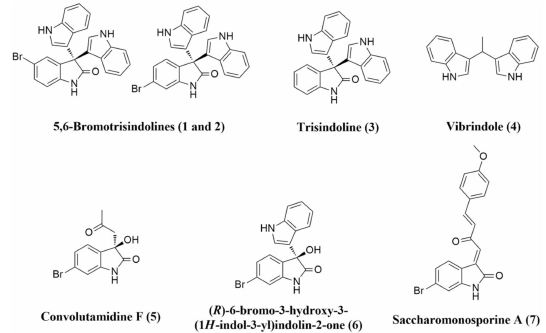
Figure 1. Some examples of marine-derived indole